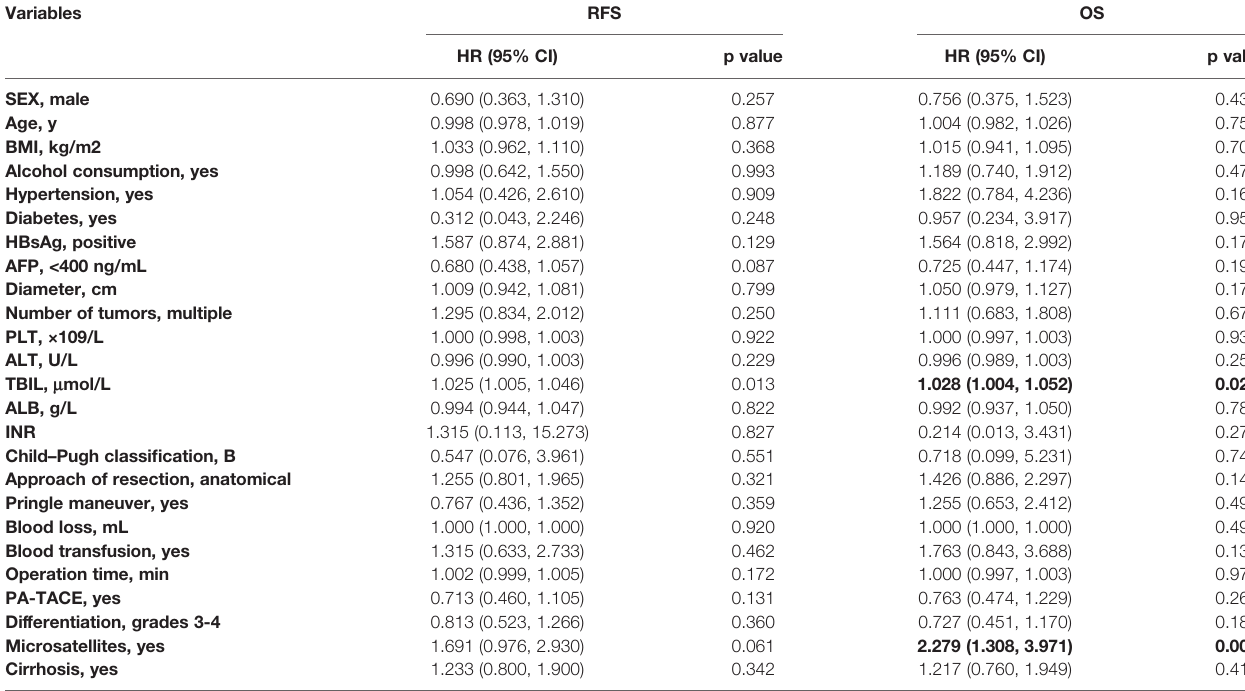
TABLE 5 | Univariate analysis for RFS and OS of HCC patients with MPVI in the PSM cohort. Variables RFS OS